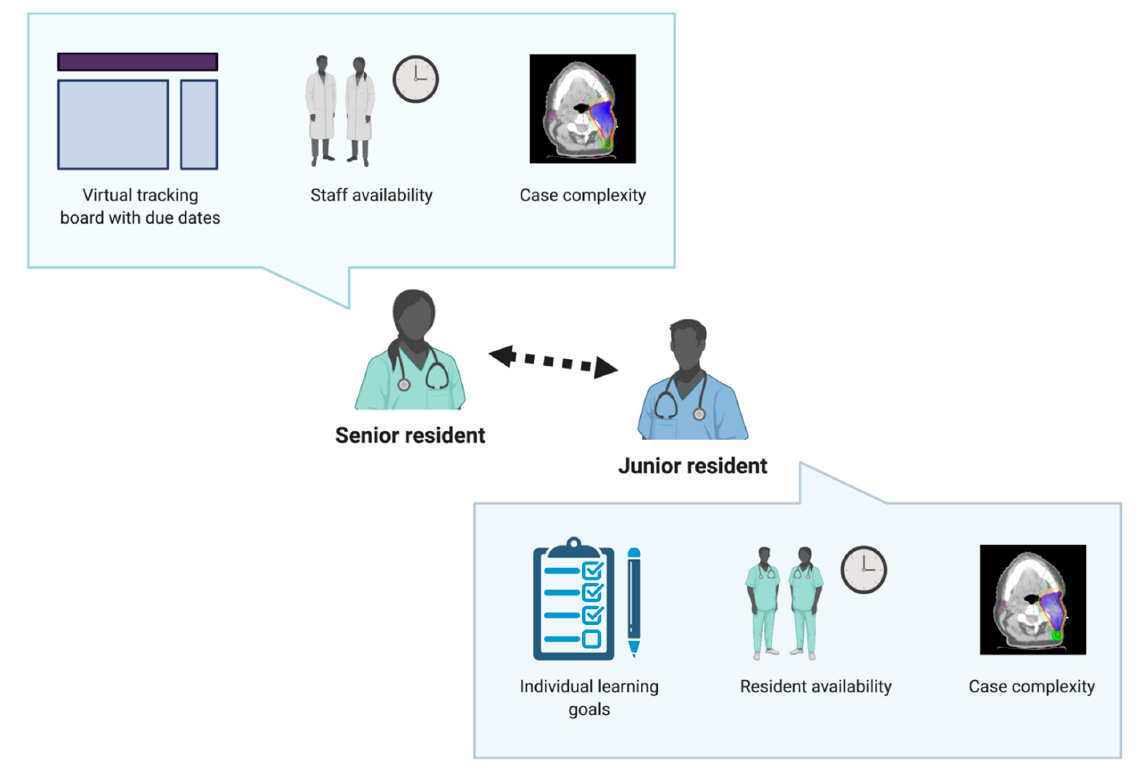
Figure 1. Mentorship model for case selection. Cases for resident learners were selected following discussion by senior and junior residents. Created with BioRender.com.